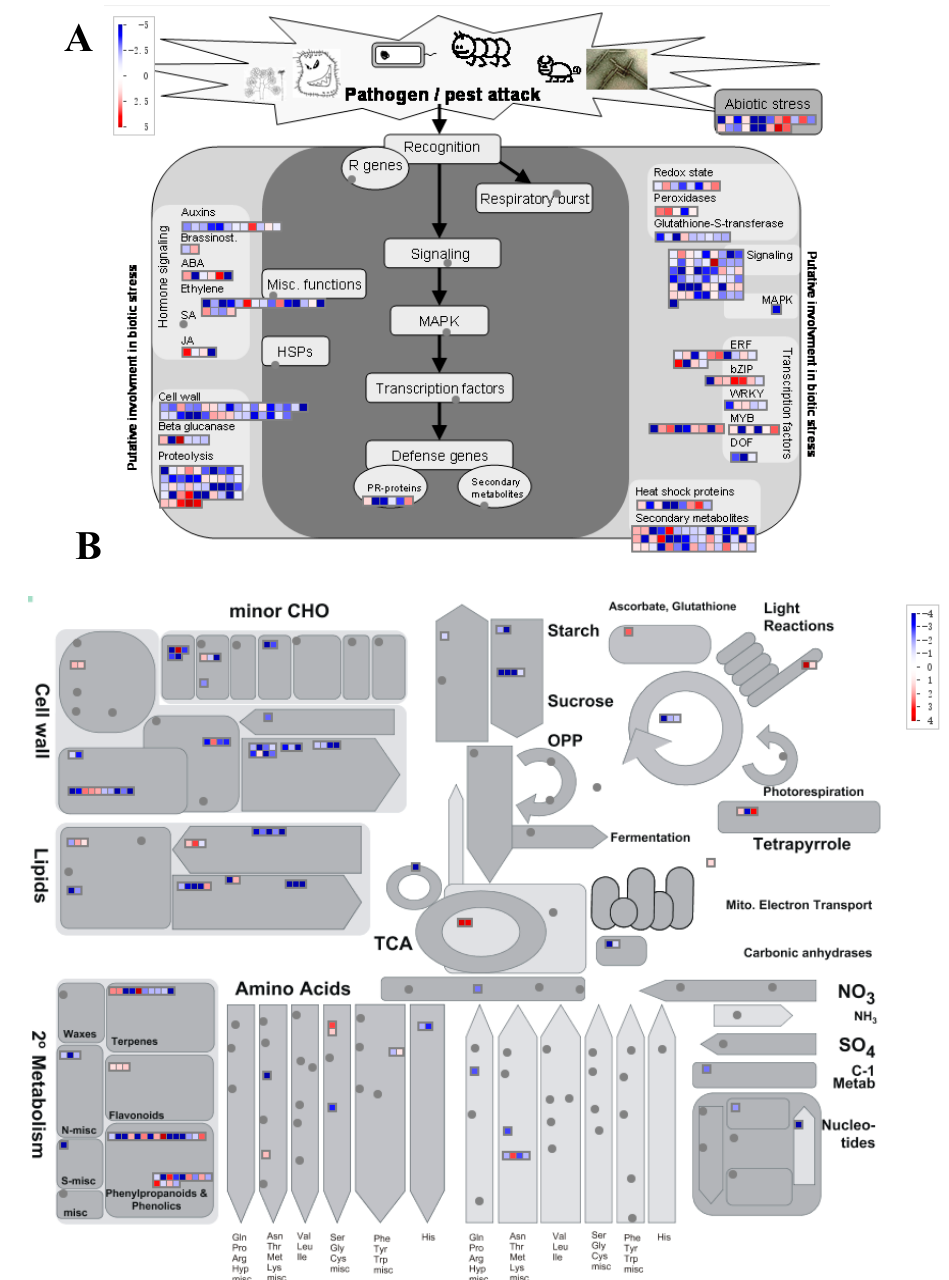
Figure 4. Common responsive genes assigned to biotic stress ( A ) and metabolism ( B ) categories based on Mapman software. The red to blue color indicates the fold changes of Melampsora larici-populina (MLP)-responsive genes. The biotic stress pathway consisted of the genes that participated in abiotic stress, redox, signaling, transcription factors, heat shock proteins, Pathogenesis protein, hormone relative genes, as well as the genes implicated in cell wall and proteolysis. For metabolism pathway, genes involved in carbon fixation and metabolism, cell wall, lipids metabolism, major nutrition uptake, and metabolism, as well as second metabolism, were included.